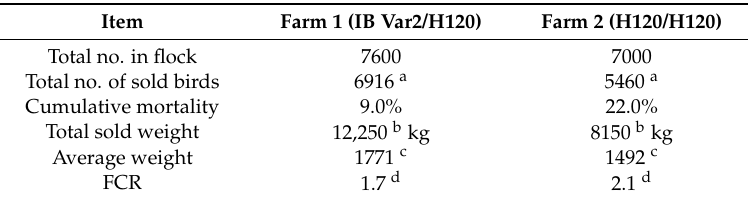
Table 2. Comparative flock performance data of farm 1 and 2.